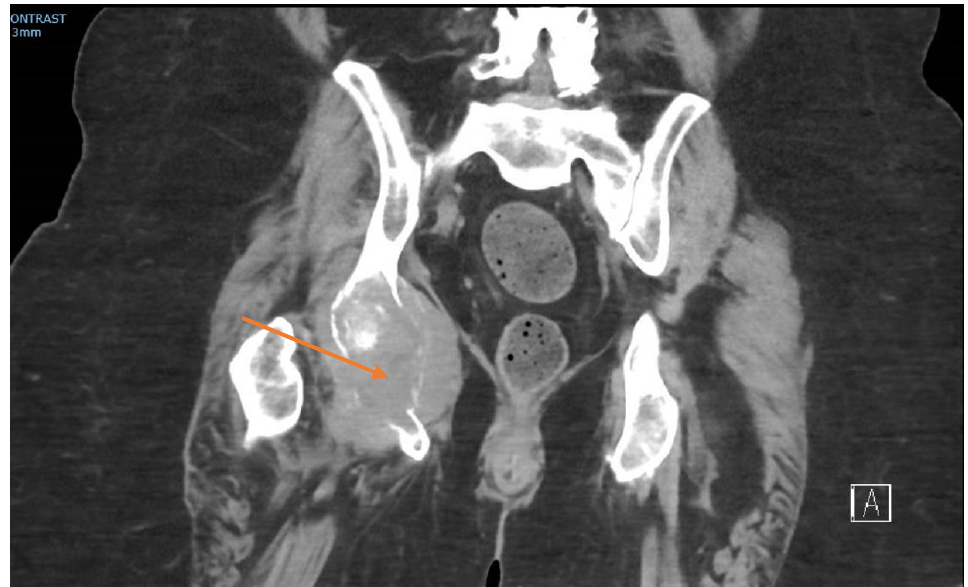
Figure 3. Coronal CT pelvis showing lytic destruction of the right ischium (arrow), with soft-tissue mass extension.